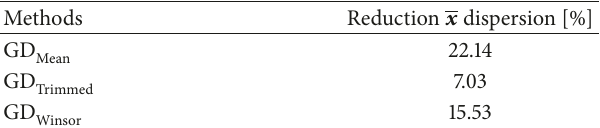
Table 54: Contaminated 𝜒 2 with 20 points. Table 55: Contaminated 𝜒 2 with 50